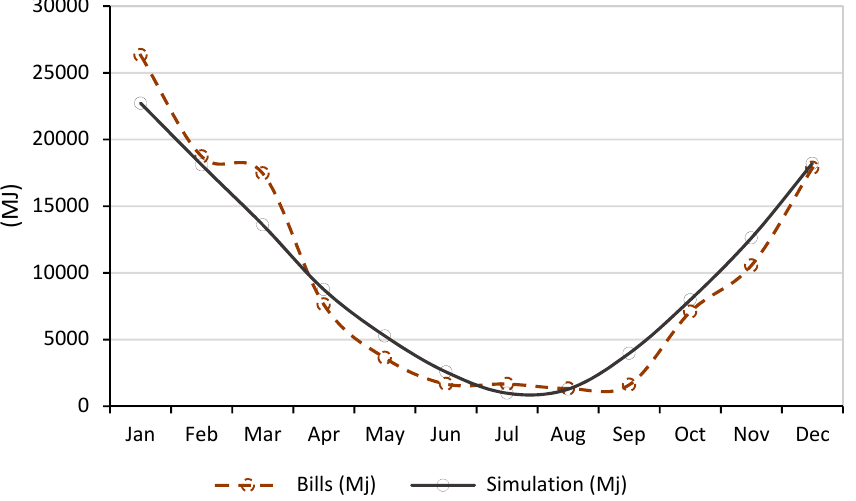
Figure 5. Monthly energy consumption of the experimental and simulated model .